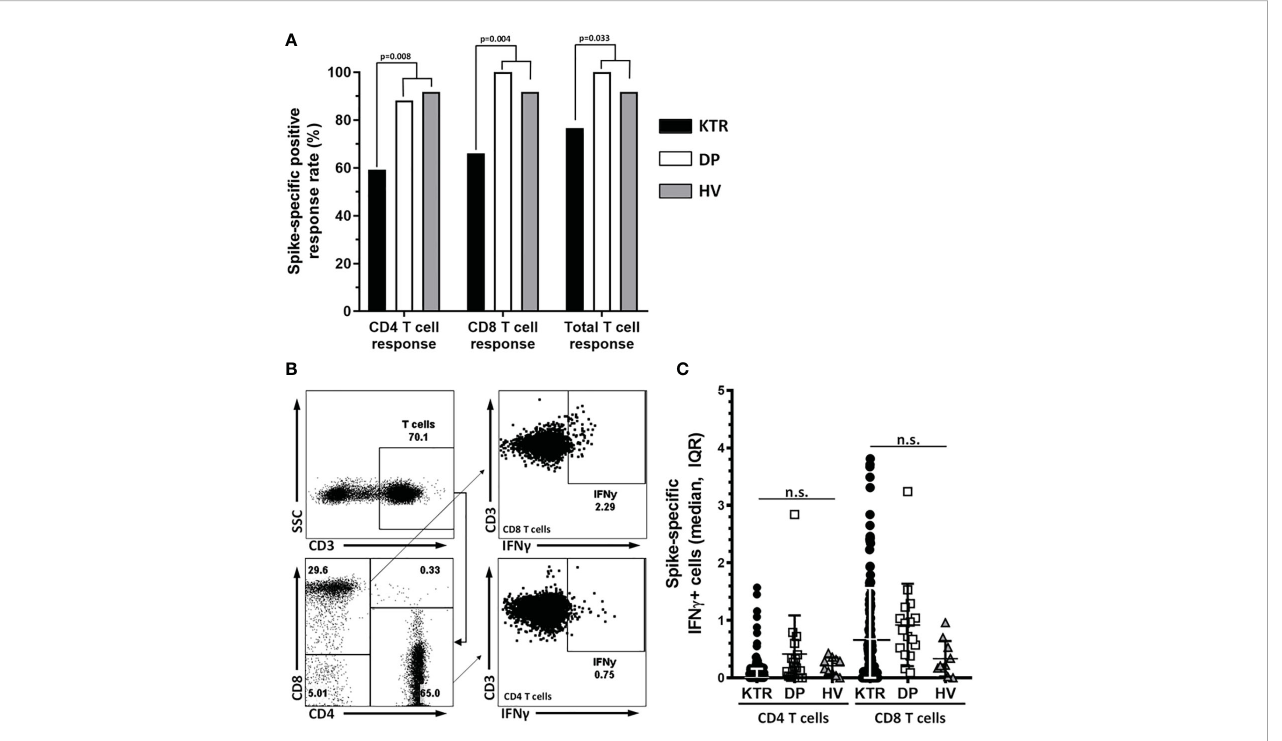
FIGURE 2 Cellular response rate after the third dose of vaccine. (A) Cellular response rate in CD4, CD8 and total T lymphocytes. A spike-speci fi c response of IFN g producing T-cells (%) >0.05 was consider as positive. The Y axis represents the response rate in CD4, CD8 and total T lymphocytes, for each subgroup of patients. (B) DotPlots show the gatting strategy to analyze the response to interferon gamma after stimulation of PBMC with the protein S peptide pool in CD8 and CD4 T cells. (C) Graph show Spike-speci fi c IFN g + cells in CD4 and CD8 T cells median and IQR of KTR, DP and HV after three doses of vaccination. The median percentage of IFNy-producing CD4-T cells were 0.17% (0-0.90 IQR) in KTR, 0.20% (0.07-0.50 IQR) in DP and 0.29% (0.09-0.35 IQR) in HV (p=0.820). In the case of CD8-T cell response the median percentages were: 0.41% (0-1.06 IQR) in KTR, 0.83% (0.46-1.13 IQR) in DP